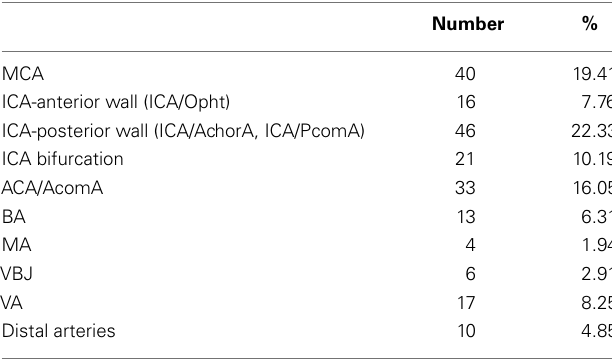
Table 1 | Quantity and distribution of the treated aneurysms from January 2002 to December 2012 for a total of 206 aneurysms in 173 patients .